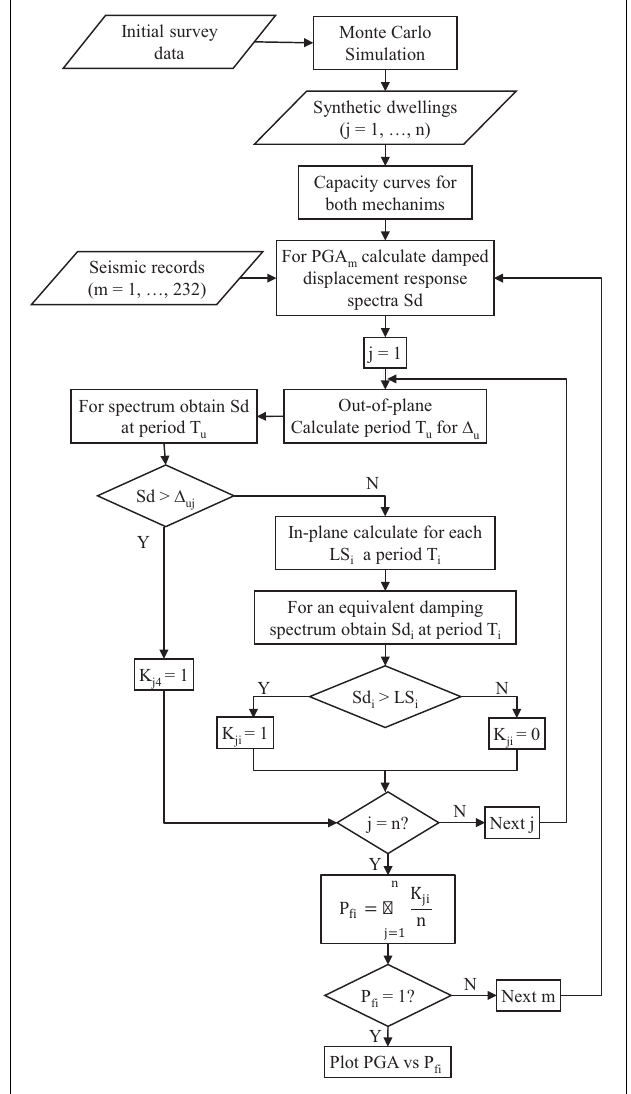
FIGURE 7 | Flowchart of the process used for the derivation of fragility